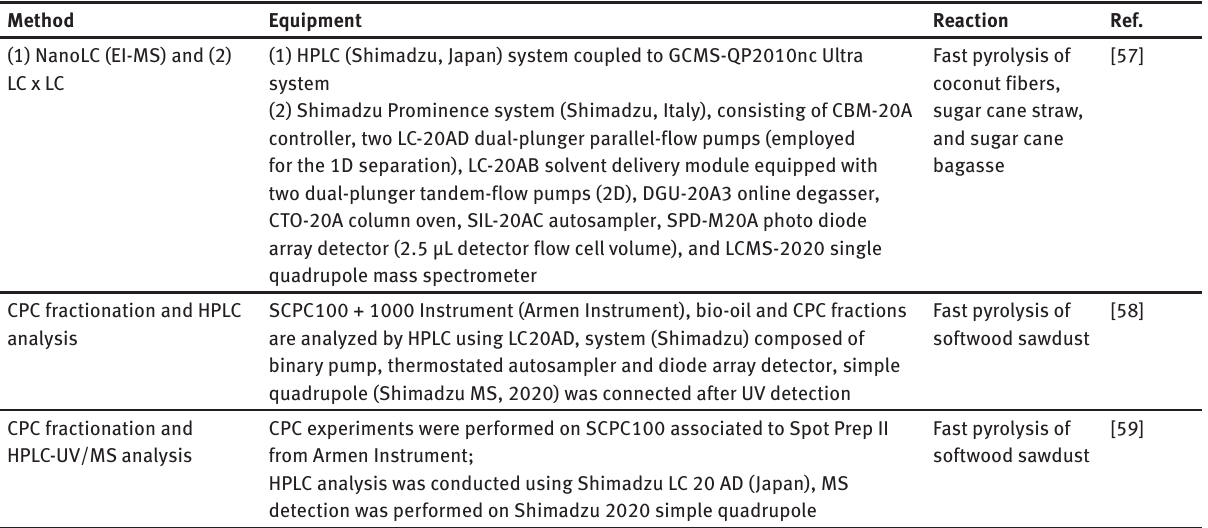
Table 5 Novel chromatographic methods of bio-oil